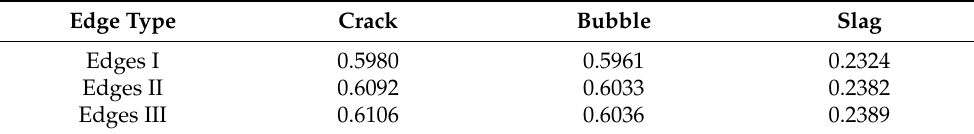
Table 2. The SSIM values of three different images with a single